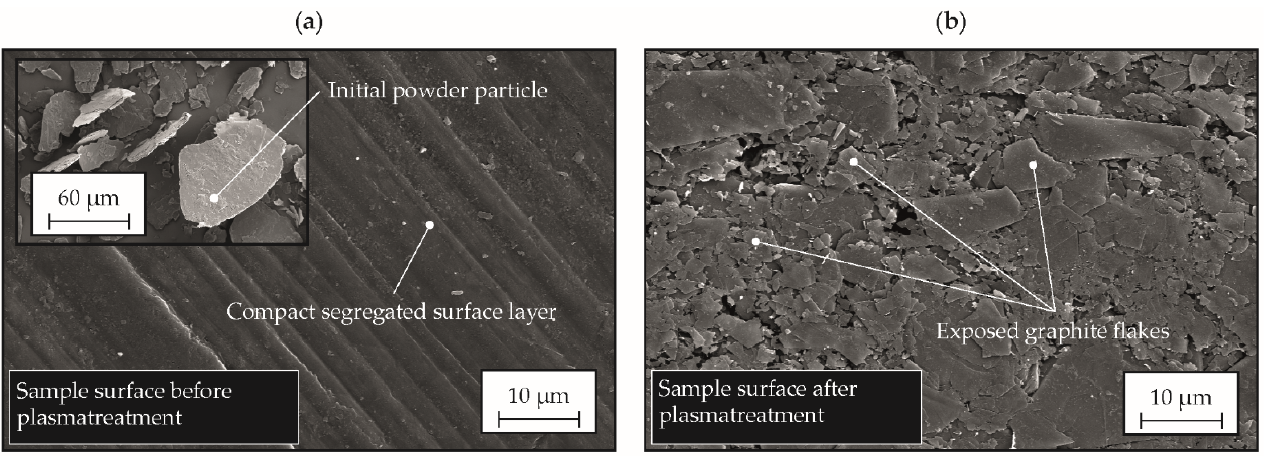
Figure 7. Scanning electron microscope images of the untreated ( a ) and the plasma-treated ( b ) sample surface.